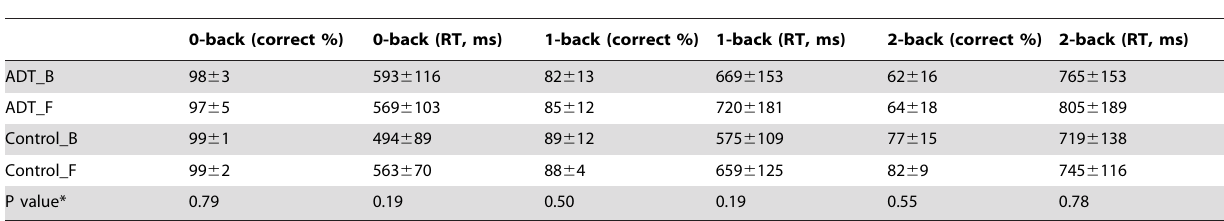
Table 2. Performance in the N-back working memory task.